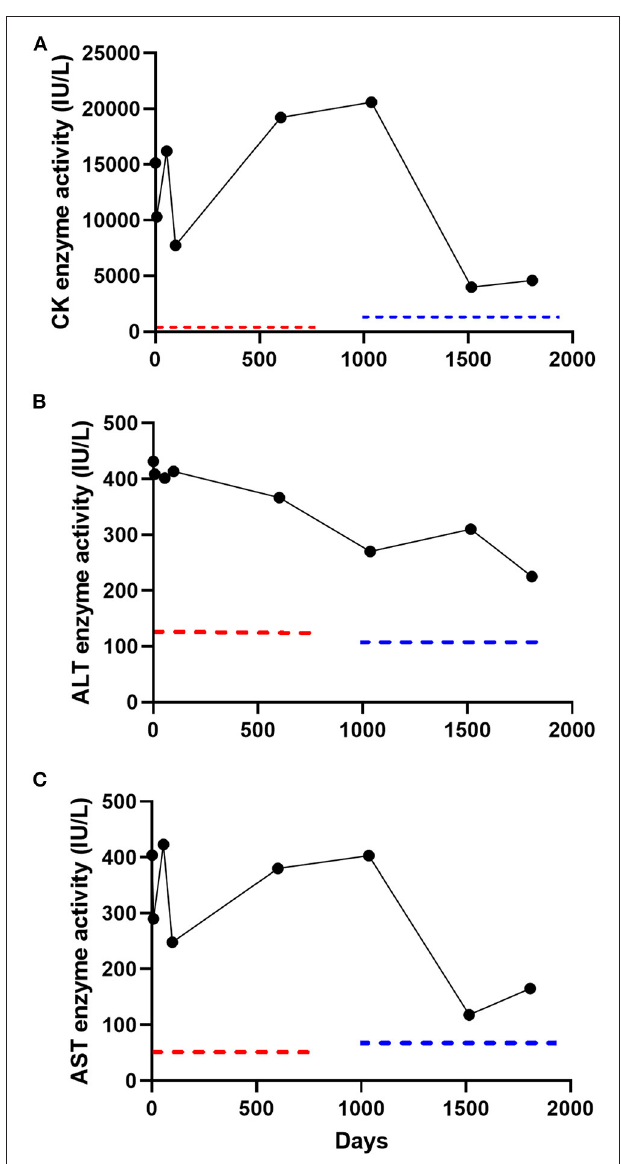
FIGURE 1 | Serial serum creatine kinase (CK) (A) , alanine transaminase (ALT) (B) , and aspartate aminotransferase (AST) (C) enzyme activity measurements in a subclinical dog over 1,807 days (5 years). Two reference laboratories were used over the 5-year follow-up period (laboratory A; day 1–602; laboratory B, day 1,036–1,807). Reference intervals for laboratory A included CK (10–200 IU/L), ALT (18–121 IU/L), and AST (16–55 IU/L) and laboratory B included CK (59–895 IU/L), ALT (12–118 IU/L), and AST (15–66 IU/L). The dotted red and blue lines denote the upper limit of the reference interval for laboratory A and laboratory B,